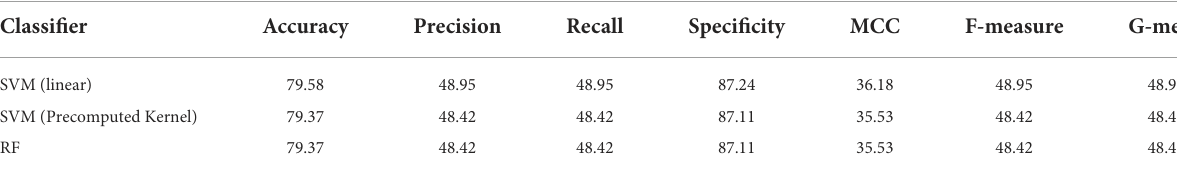
TABLE 9 The experiments outcomes of the binary and multi-class classification for SVM (linear kernel), SVM (precomputed kernel), and RF approaches using APTOS-2019 and IDRiD datasets. APTOS-2019 dataset with 5